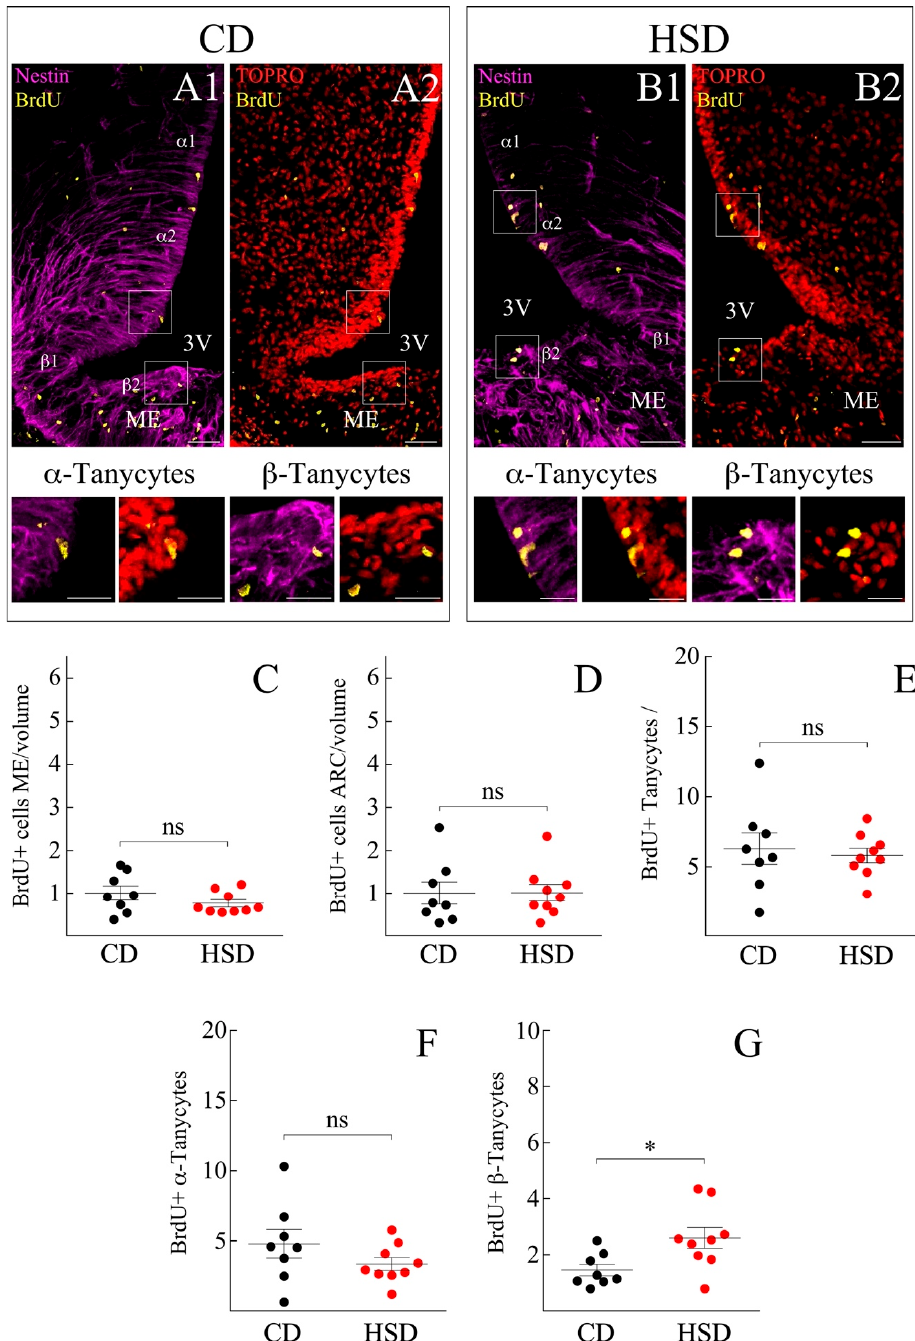
Figure 3. Hypothalamic cell proliferation of rats exposed to HSD and CD. ( A1 – B2 ) Immunohisto- chemistry of frontal hypothalamus sections of rats exposed to a control diet (CD; ( A1 , A2 )) and a diet rich in sucrose (HSD; ( B1 , B2 )); with antibodies that recognize nestin (purple), BrdU (yellow) and their co-localization with the nuclear marker TOPRO (red). The images in the lower panel show a magnification of the insets in ( A1 – B2 ), pointing to the proliferation of the α 2 and β 2 tanycytes, respec- tively. Scale bar ( A1 – B2 ): 50 µ m. Scale bar insets: 20 µ m. 3V, third ventricle. ME, Median Eminence. ( C – G ) Quantification of the number of dividing cells in ME ( C ) and in ARC parenchyma ( D ) nor- malized to the volume of tissue analyzed and relative to the control condition. ( E – G ) Number of proliferative tanycytes, without distinction of subpopulations ( E ), number of proliferative α tanycytes ( F ) and β 2 ( G ). n = at least 26 slices and 8 animals for each condition. The data is represented as the mean ± sem; (*) p < 0.05, Student’s t